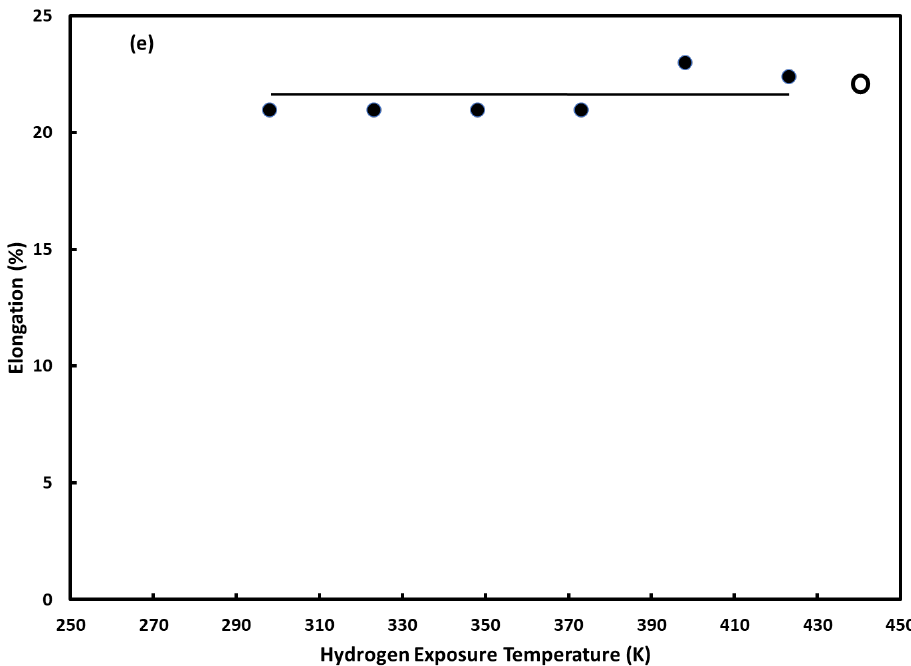
Figure 3. Elongation at failure as a function of hydrogen absorption/desorption cycling temperature: ( a ) palladium–copper (5 wt.% Cu); ( b ) palladium–copper (10 wt.% Cu); ( c ) palladium–copper (15 wt.% Cu); ( d ) palladium–copper (20 wt.% Cu); ( e ) palladium–copper (25 wt.% Cu). For comparison, elongation at failure ( ○ ) of vacuum-annealed specimens is included and positioned at an arbitrary temperature.